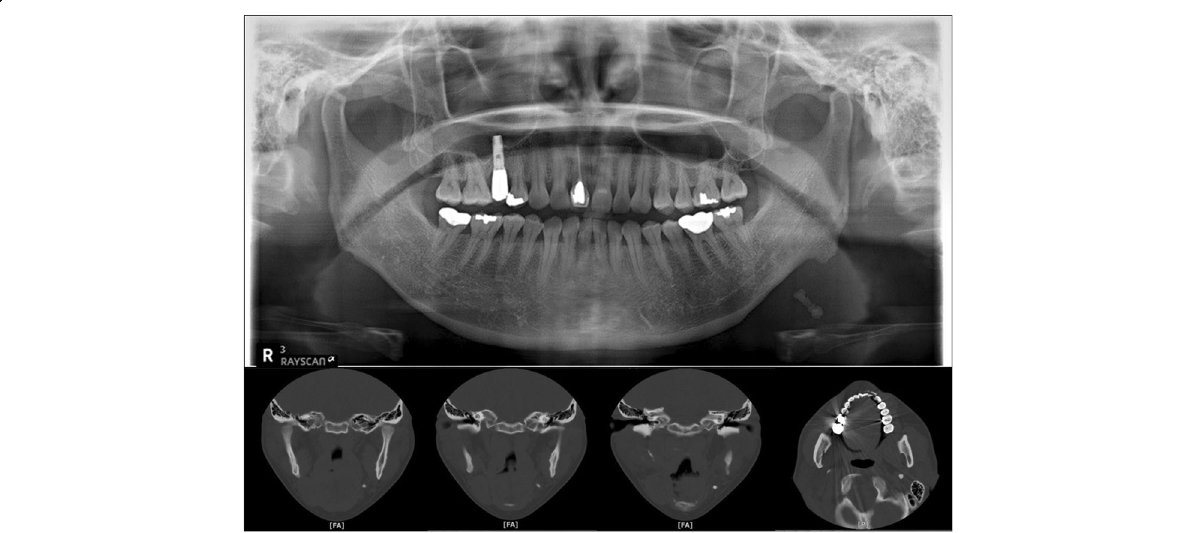
Fig. 1 The panoramic radiograph showed an elongated radiopaque structure imposed on the left submandibular area ( top ). Computerized tomographic (CT) scan of the mandibular region showed the presence of multiple high attenuated materials and elongated sialolith located within the left Wharton ’ s duct. Very severe atrophic submandibular gland was also found ( bottom